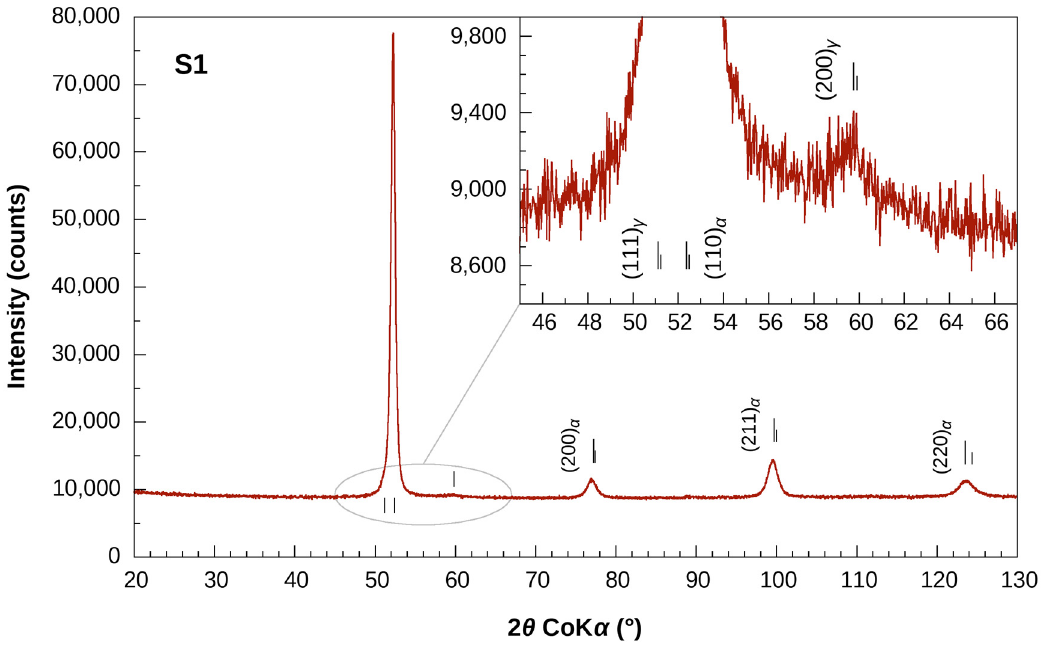
Figure 3. XRD pattern of sample S1.